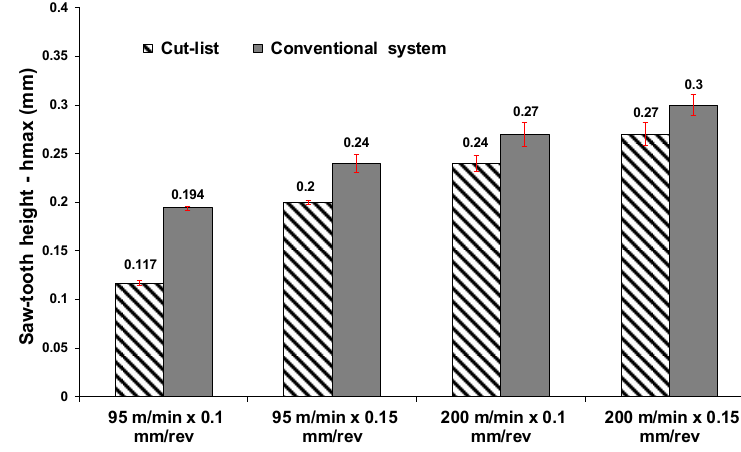
Figure 19. Average saw-tooth height of serrated chips at various cutting conditions.